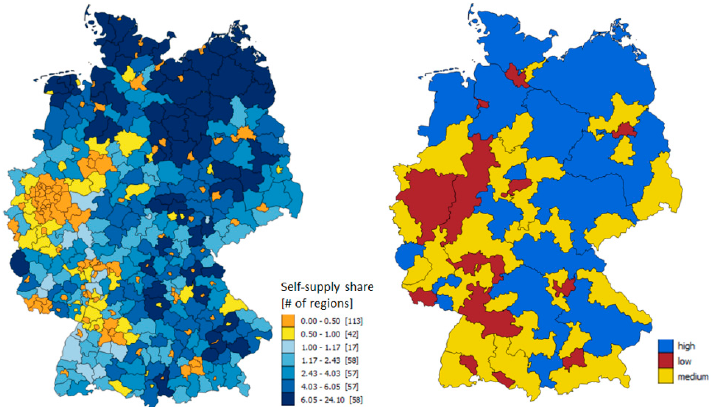
Figure 3. Potential regional self-supply for assumed 1000 TWh electricity demand ( left ) and the clustered regions for the model according to the defined self-supply category (high–medium–low) ( right ).